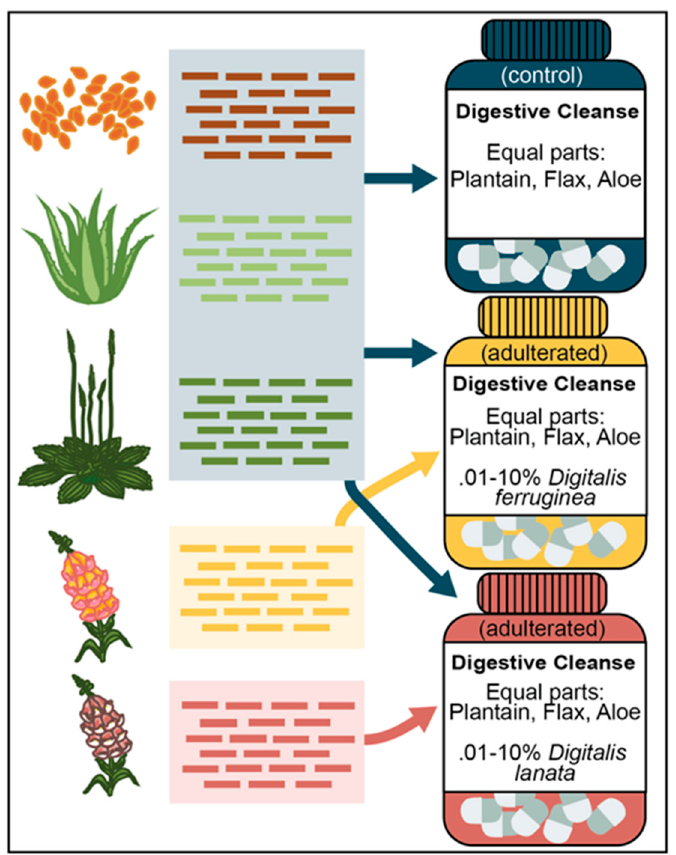
Figure 1. Overview of mock dietary supplement sample design. All mock supplement mixes were created in silico from sequencing data. The control sample consisted of equal parts Plantago major , Aloe vera , and Linum usitatissimum reads. The adulterated supplement mixes contained the same background as the control but also included 0.01%, 0.025%, 0.05%, 0.1%, 0.25%, 0.5%, 1%, 2.5%, 5%, and 10% of either Digitalis lanata or Digitalis ferruginea